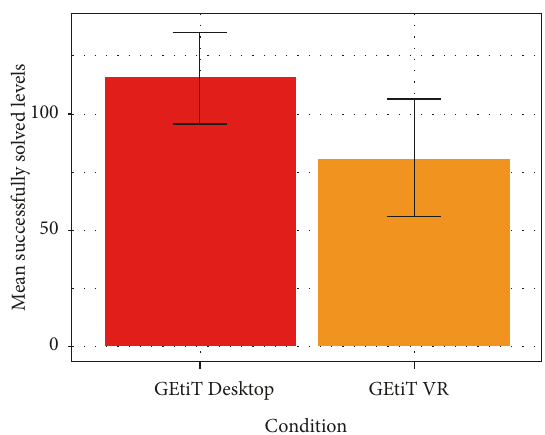
Figure 12: Graphical comparison of the mean gameplay progress between the desktop-Group and the vr-Group . Error bars indicate standard